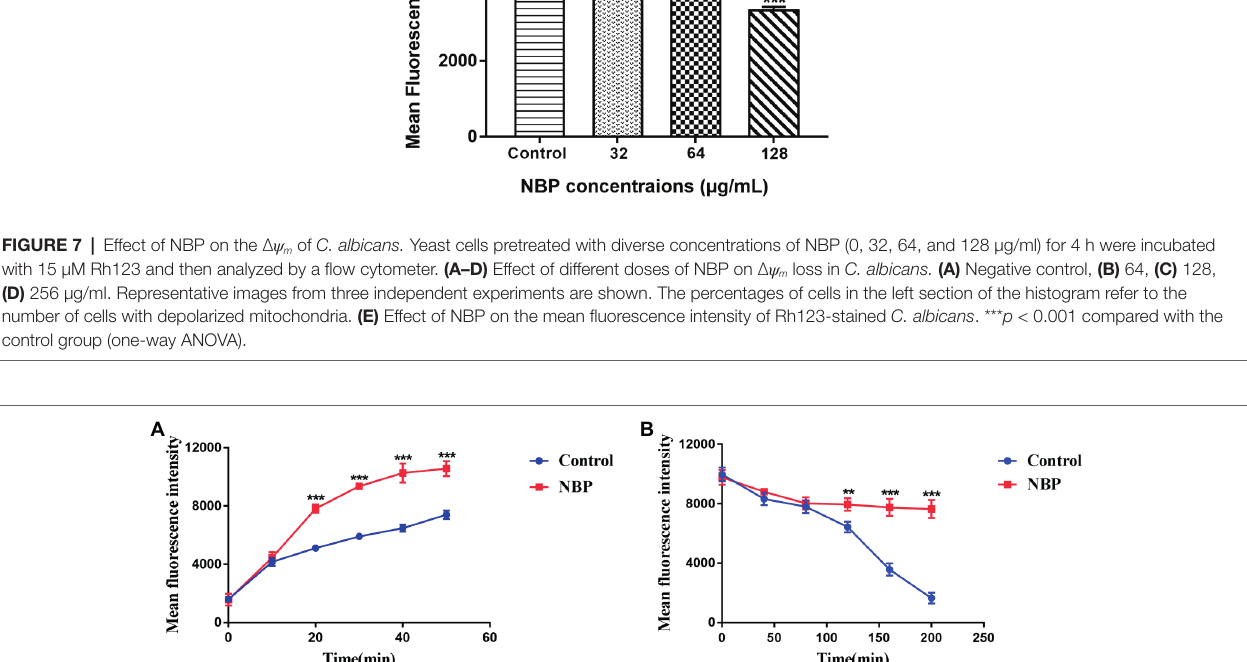
FIGURE 8 | Effect of NBP on drug uptake (A) and efflux (B) of C. albicans tested by Rh6G assay. The concentration of NBP is 32 μg/ml and cells treated without NBP were served as the control group. Mean fluorescence intensity represented intracellular Rh6G and were measured by a flow cytometer. Values represent the means ± standard deviation of three replicates. ** p < 0.01 and *** p < 0.001 compared with the control group (unpaired t